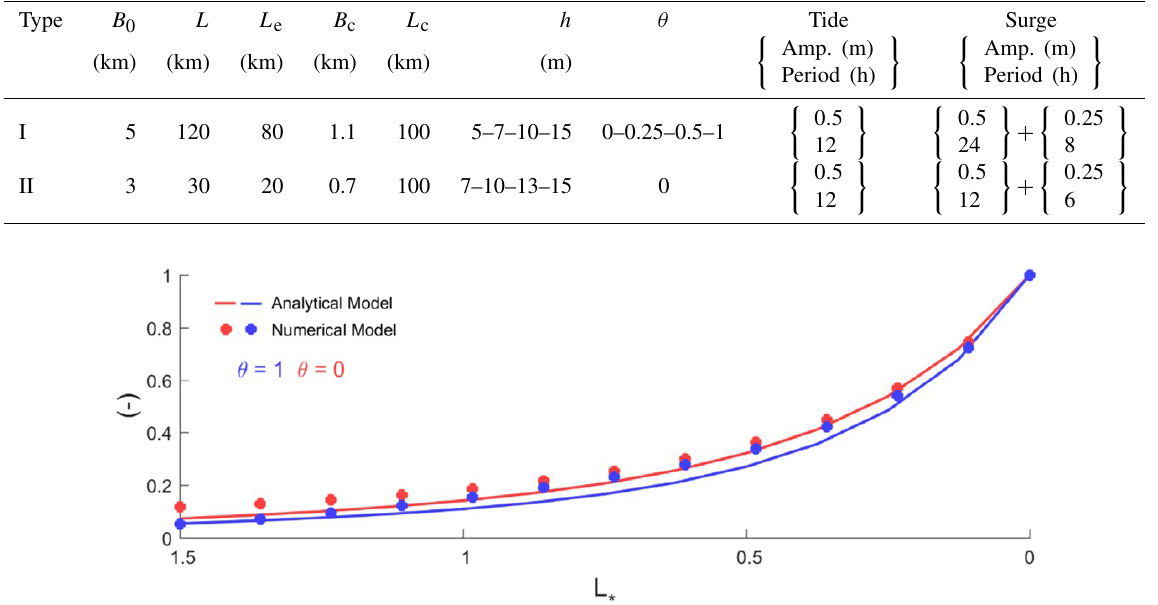
Figure 3. Dominant tidal constituent ( M 2 ) amplitude in a 5m deep estuary for three tide models ( K 1 , M 2 , and M 3 ) with and without river flow ( θ = 0–1). The x axis is the estuary length normalized by the convergence length scale ( L ∗ = x/L e ), and the y axis is normalized by M 2 amplitude at the ocean boundary ( L ∗ =